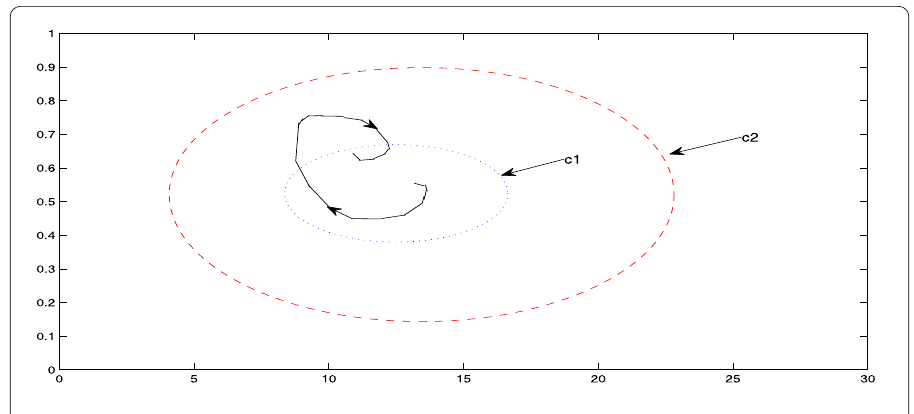
Figure 7 Phase plane plot of closed-loop system